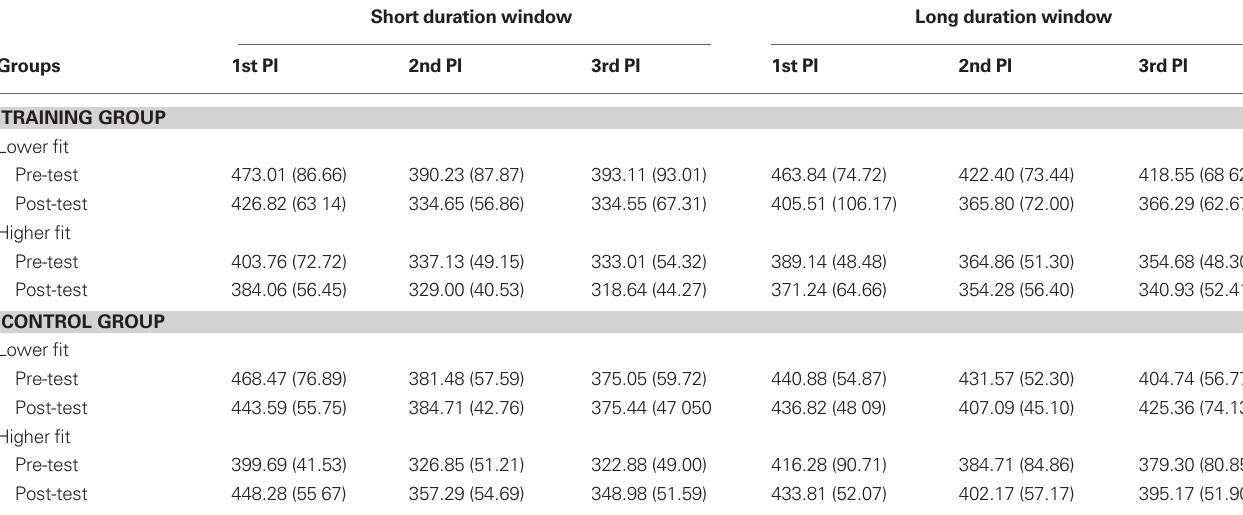
Table 3 | mean initiation time (in ms) and standard deviation (in parentheses) of the choice rT as a function of duration condition and Pi. Short duration window Long duration